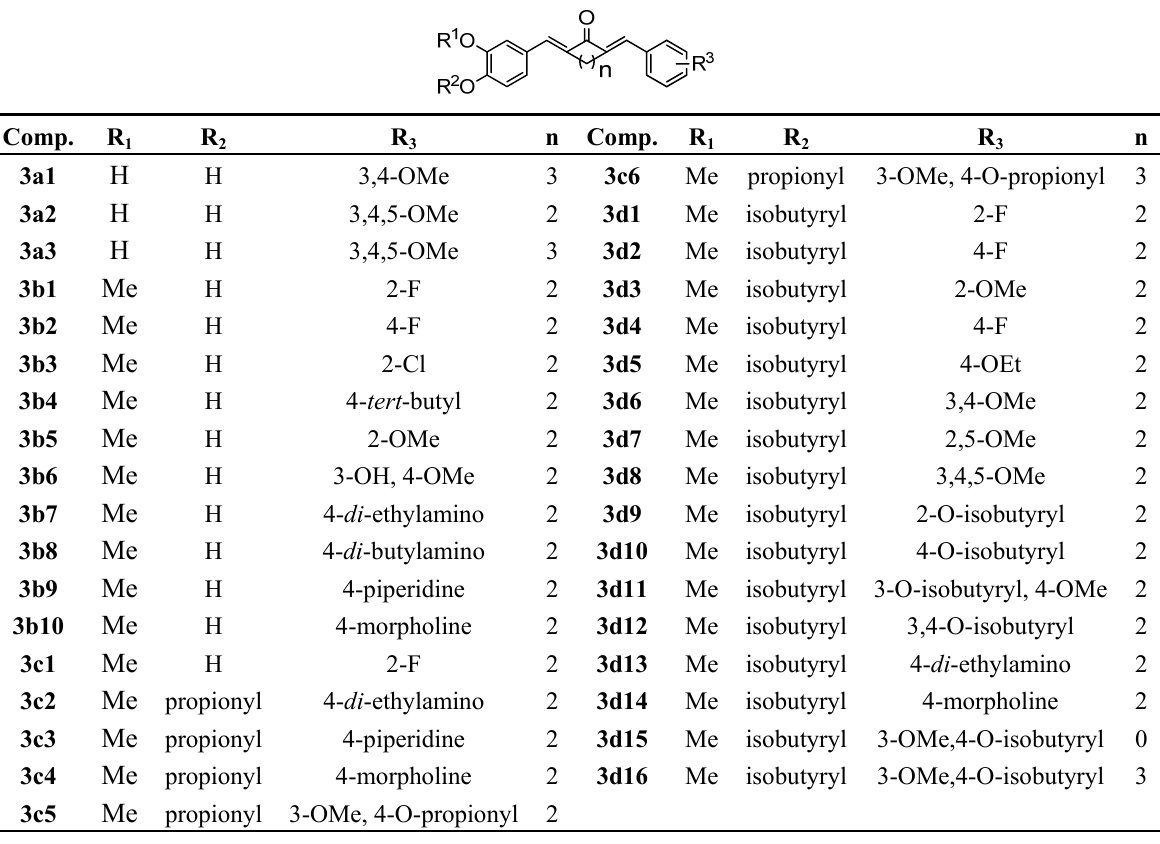
Table 1. The chemical structures of the synthetic curcumin analogs.